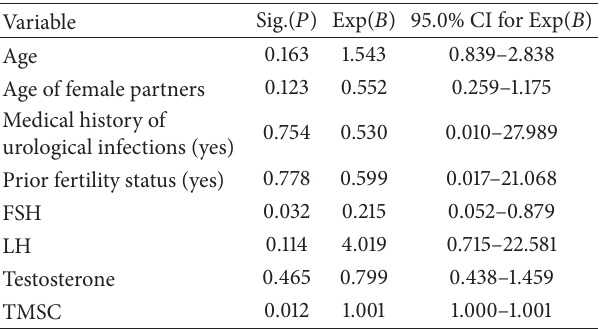
Table 2: Results of multivariate Cox proportional hazard model analysis.